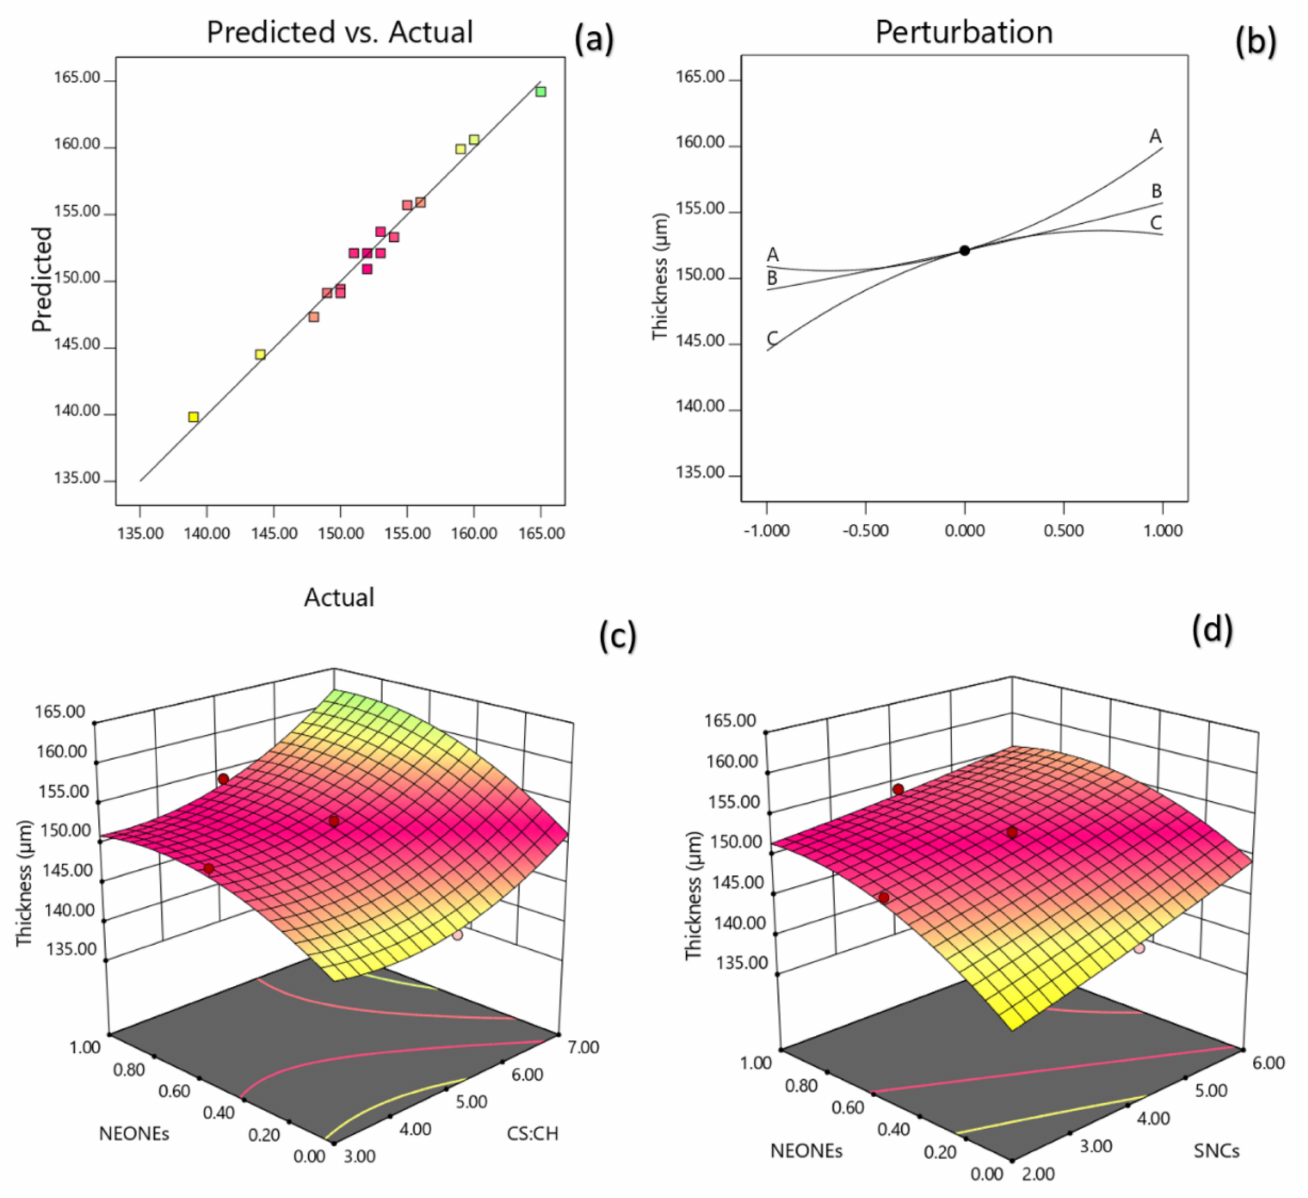
Figure 4. Counter and perturbation graphs ( a , b ), the interaction between CS:CH and SNCs concentration and also interaction between SNCs and NEONEs concentration on thickness of the produced film ( c , d